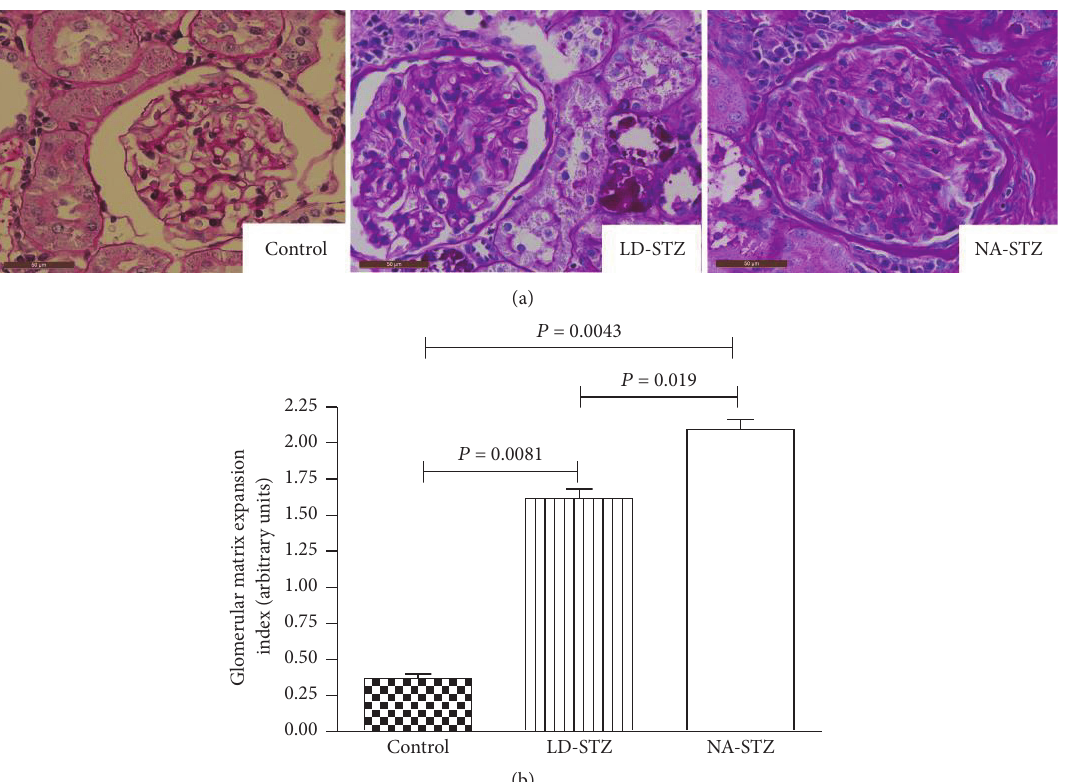
Figure 10: Periodic acid-Schiff (PAS) staining of renal glomerular regions from control and diabetic rats at the end of the experiment at week 30. (a) Representative images of PAS-stained kidney specimens from all experimental groups (magnification × 640). Glomerulus from controlnondiabeticrathasopenedcapillarylumensandthefewestamountsofmesangialcellspercapillarytuft.Moderatediffuseexpansionof mesangium is observed in both diabetic groups. NA-STZ-injected diabetic rat shows markedly more expanded mesangium and endocapillary hypercellularity. (b) Graphic representation of semiquantitative indices of glomerular matrix expansion that, as indicated, are determined from at least 35 glomeruli in each kidney. Means and standard deviations are